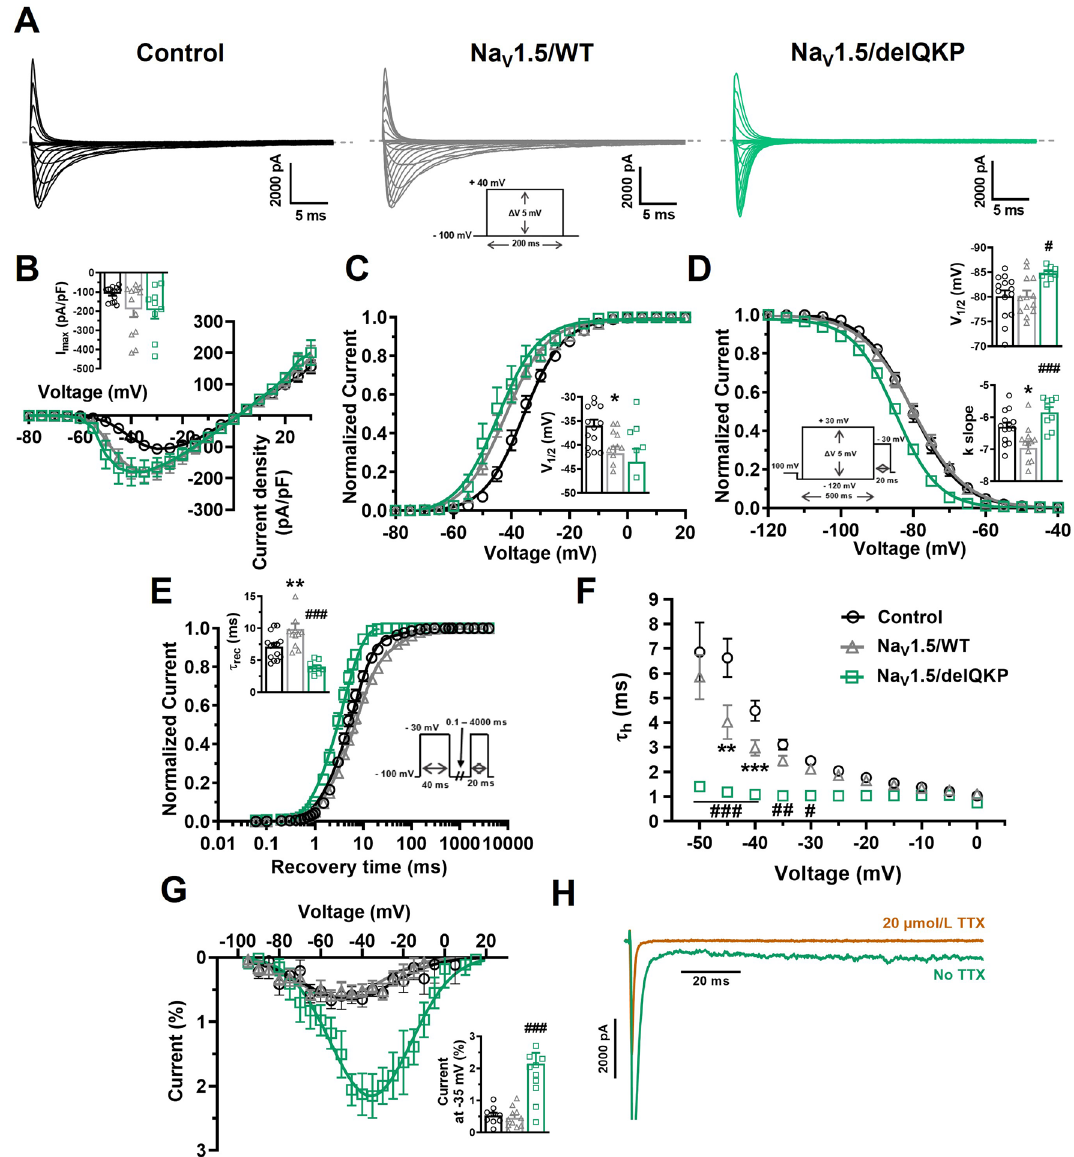
Figure 6. Altered biophysical properties of Na + channel in KO iPSC-CMs expressing Na V 1.5/ΔQKP. ( A ) Representative Na + currents recorded in control and KO iPSC-CMs transfected with Na V 1.5/WT or Na V 1.5/delQKP. The dashed line represents zero current. The currents were obtained using 200 ms pulses from − 100 to + 40 mV in + 5 mV increment. ( B ) Normalized intensity/voltage relationships (I/V) recorded in control (n = 14), Na V 1.5/WT (n = 13) and Na V 1.5/delQKP (n = 9) iPSC-CMs. Na + current densities were measured by normalizing current amplitudes to membrane capacitance. Inset shows graph of I max . ( C ) Steady-state activation of Na + currents. Activation curves were generated using a standard Boltzmann distribution: G(V)/G max = 1/(1 + exp (− (V − V 1/2 )/k)). Inset shows graph of V 1/2 . ( D ) Steady-state inactivation of control (n = 14), Na V 1.5/WT (n = 13) and Na V 1.5/delQKP (n = 9). Inactivation currents were obtained using 20-ms test pulses to − 30 mV after a 500-ms pre-pulse to potentials ranging from − 120 to + 30 mV. The inactivation values were fitted to a standard Boltzmann equation: I(V)/I max = 1/(1 + exp ((V − V 1/2 )/k)) + C. Inset shows graph of V 1/2 and k slope ( E ) Recovery from inactivation values recorded from control (n = 14), Na V 1.5/WT (n = 12) and Na V 1.5/delQKP (n = 9) iPSC-CMs. The cells were depolarized to − 30 mV for 40 ms from a holding potential of − 100 mV to inactivate the Na + channels. Test pulses were then applied at − 30 mV for 20 ms to measure current amplitudes, with an interval ranging from 0.1 to 4000 ms. The resulting curves were fitted with a simple exponential equation: (A (exp (− t/τ) + C). Inset shows a graph of the recovery time constant (τ rec ). ( F ) The time constants of fast inactivation decay were plotted as a function of voltage for control (n = 14), Na V 1.5/ WT (n = 13) and Na V 1.5/delQKP (n = 9). The time constants were obtained using a simple exponential function. ( G ) Persistent Na + current/voltage relationships recorded in control (n = 9), Na V 1.5/WT (n = 11) and Na V 1.5/delQKP (n = 12) iPSC-CMs. The currents were obtained using 300 ms pulses from − 100 to + 40 mV in + 5 mV increment. Persistent Na + currents are represented as percentage of the current, obtained by normalizing the values at the end of the pulse to the maximum transient current. Inset shows graph of percentage of current at − 35 mV. ( H ) Representative persistent Na + current at − 35 mV recorded in Na V 1.5/delQKP iPSC-CMs before and after adding 20 µmol/L TTX. Bars indicate SEM. * p < 0.05, ** p < 0.01 (control vs. Na V 1.5/WT) and # p < 0.05, ## p < 0.01, ### p > 0.001 (Na V 1.5/WT vs. Na V 1.5/ΔQKP) using ANOVA and Dunnett’s post hoc tests. This figure was made using